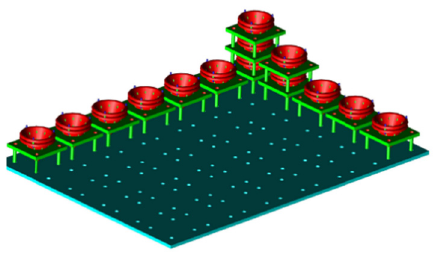
Figure 6. Tray for flower transporting and drying.